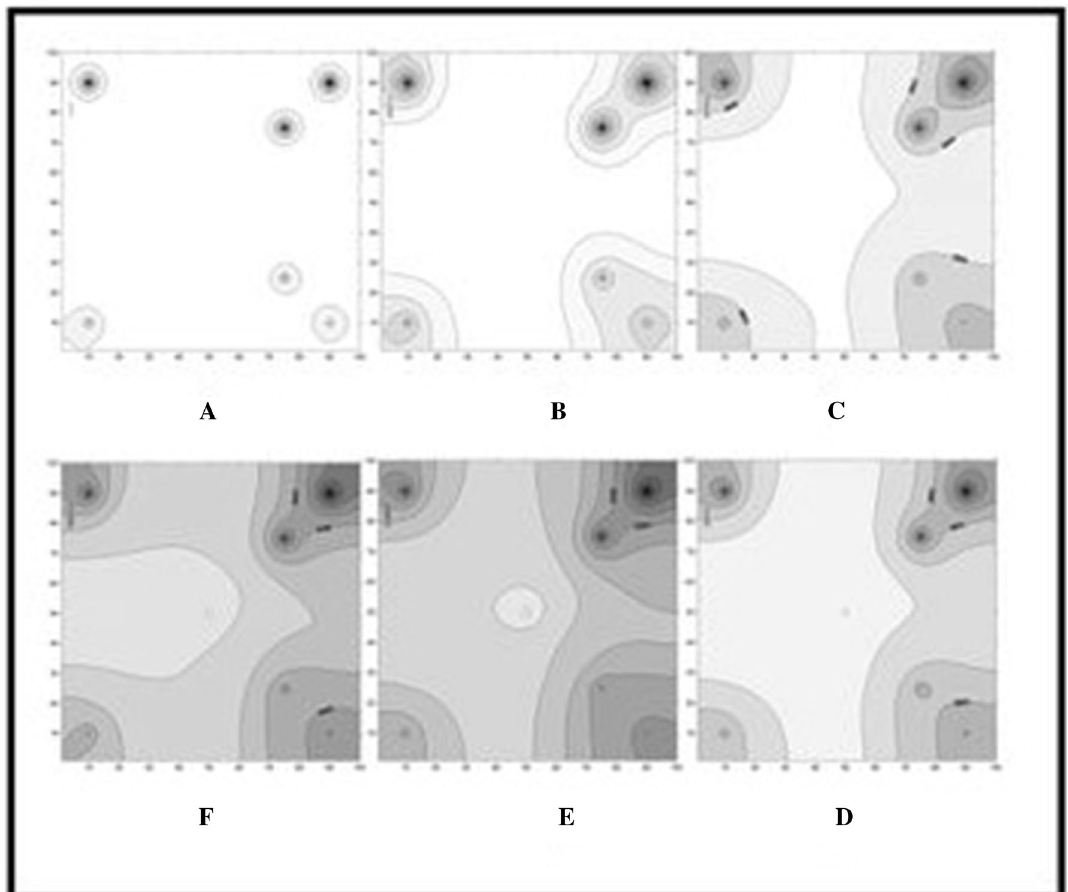
Fig. 6 Drainage radius after the first 10 days for the model (with correlation range of 625